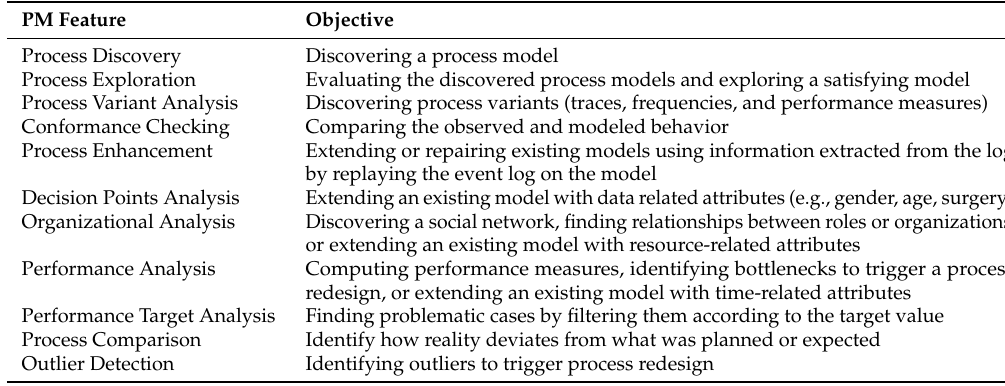
Table 3. PM Features and